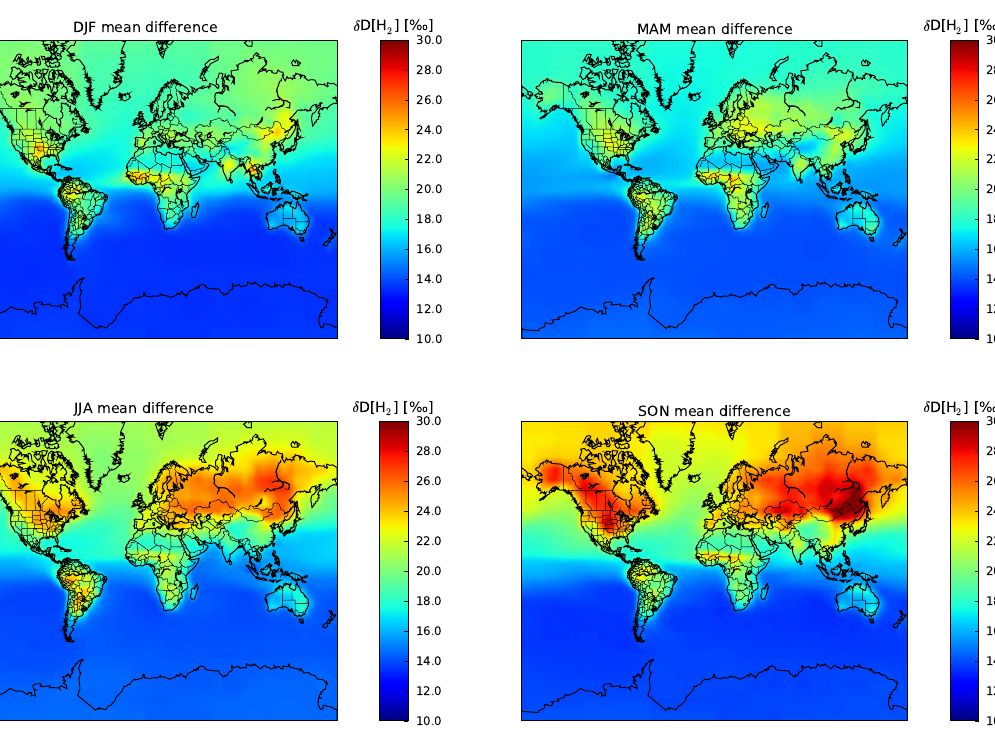
Fig. 10. Case 5 surface level seasonal mean